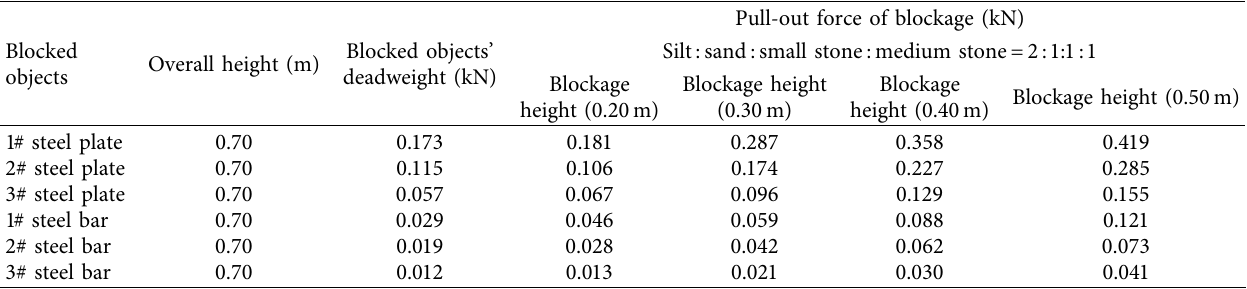
Table 7: Results of pull-out force test of underwater (mixed) blockage.